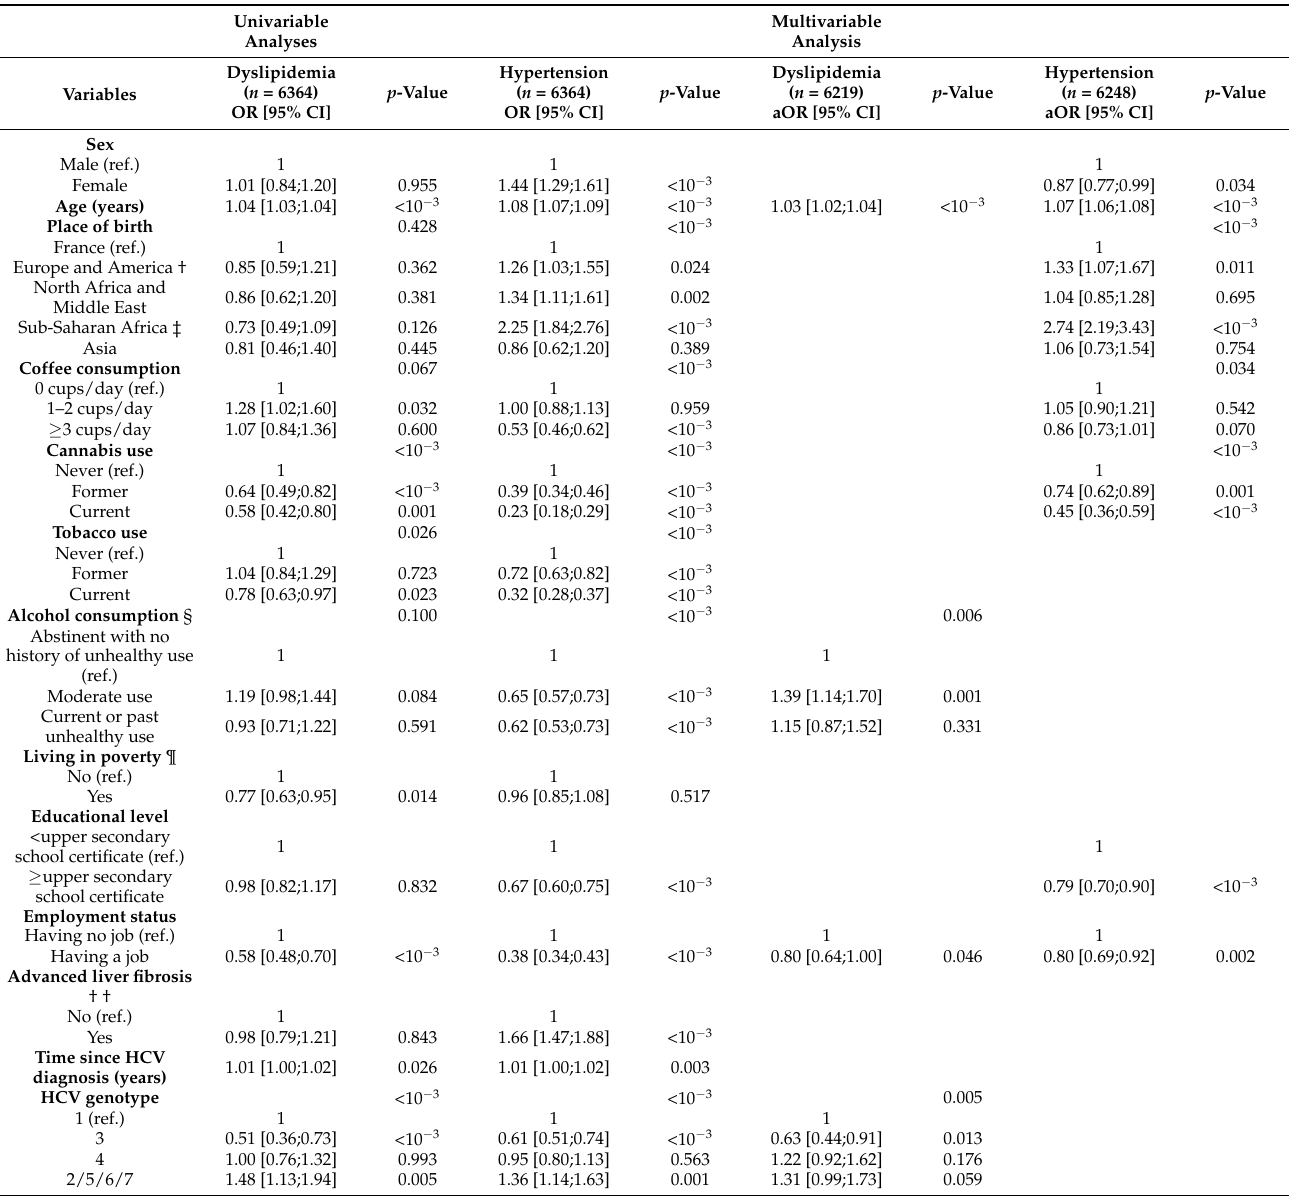
Table 2. Factors associated with dyslipidemia and hypertension (univariable and multivariable logistic regression models, ANRS CO22 Hepather cohort, n =